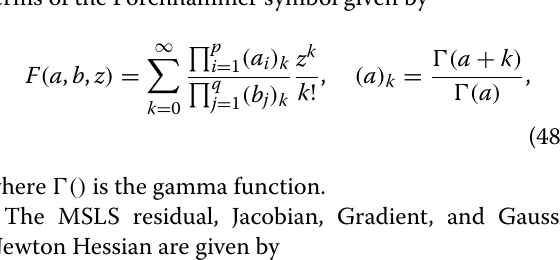
functions respectively. Experiments show how PDI